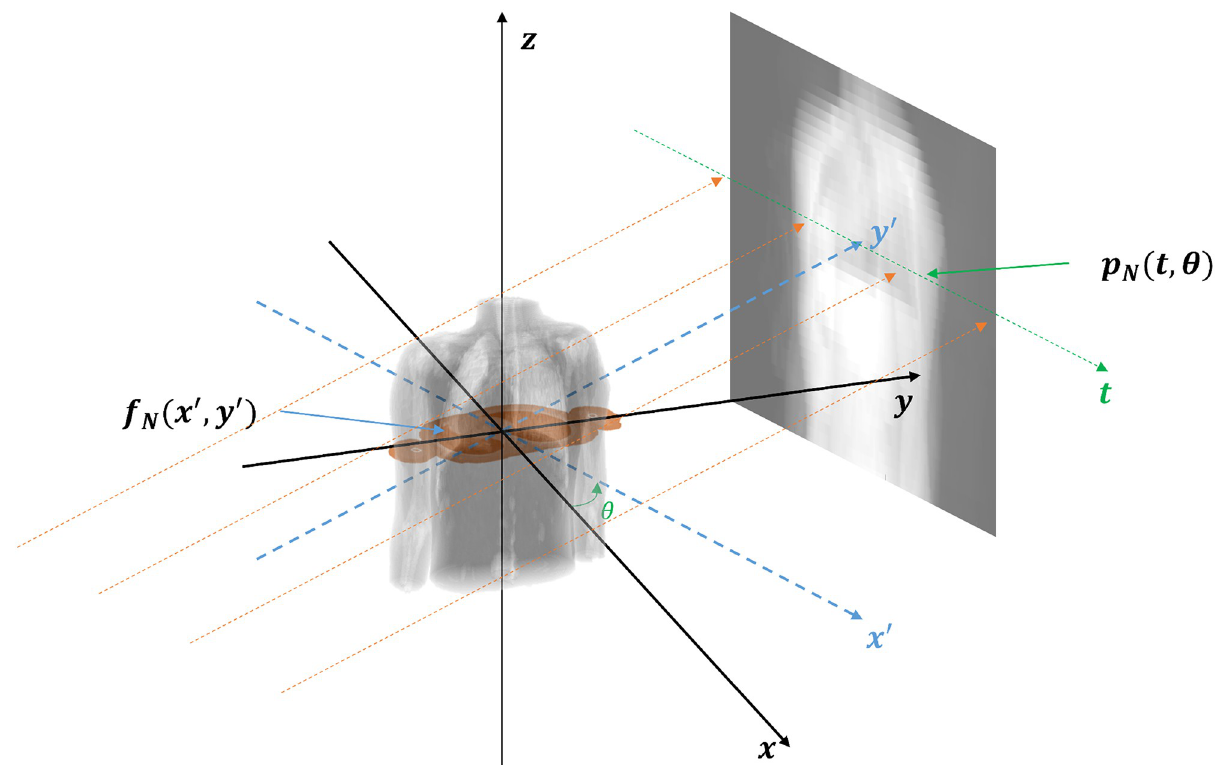
Fig 2. Rotated coordinate system in parallel-beam